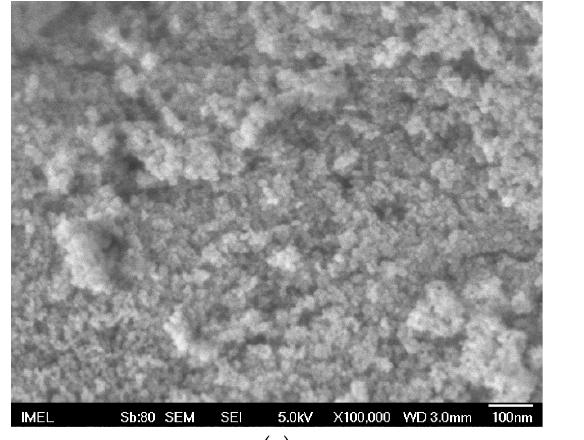
Figure 5. Energy band gap graph for N-doped TiO 2 powder.